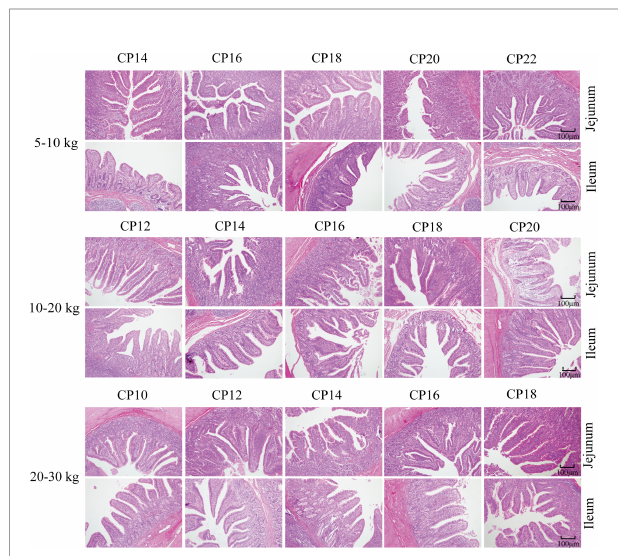
FIGURE 2 | Effects of dietary crude protein (CP) levels on the small intestinal morphology of Huanjiang mini-pigs during different growth stages ( n = 6 − 8 per group). H&E staining, 100 ×. CP, crude protein.